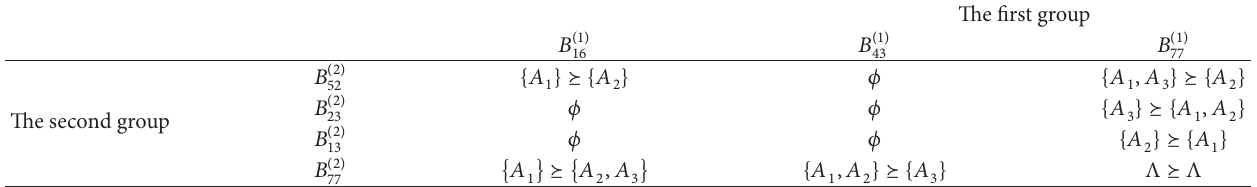
Table 7: The preference intersections for higher